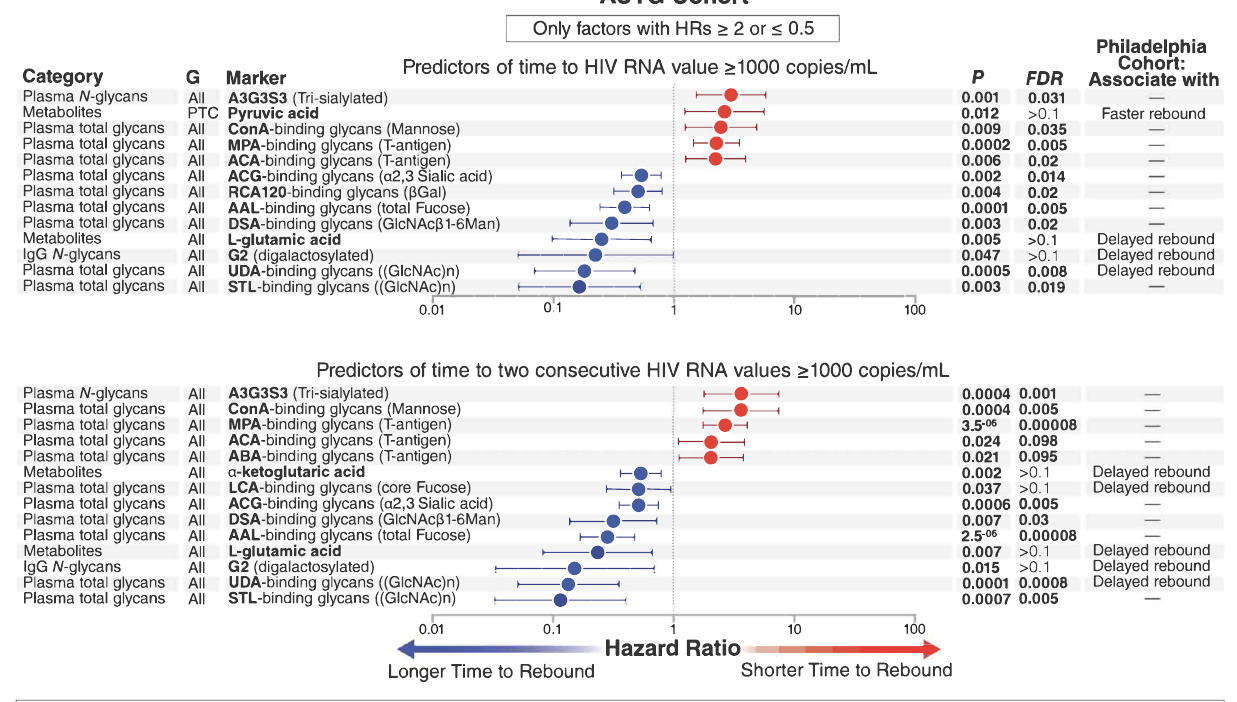
Fig. 3 Hazard ratios of plasma glycomic and metabolic markers that associated with time-to-viral-rebound in the ACTG Cohort. Cox proportional- hazards model of glycomic and metabolic markers of time to (top panel) VL ≥ 1000 copies/ml or (bottom panel) two constitutive VL ≥ 1000 copies/ml within the ACTG Cohort. Data are presented as hazard ratios with 95% con fi dence intervals. Two-sided P value of each independent variable in the model was used. False Discovery Rate (FDR) was calculated using Benjamini – Hochberg method to correct for multiple comparisons. n = 74 biologically independent samples. G = group (All = using data from all 74 participants and PTC = using data from only the 27 PTCs within the ACTG Cohort). HRs = hazard ratios. Source data are provided as a Source Data fi